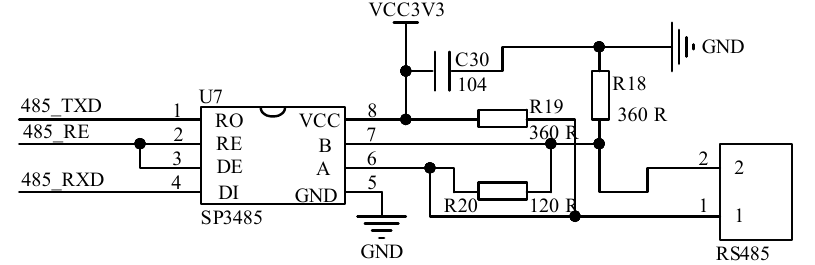
Figure 8. 485 communication circuit.